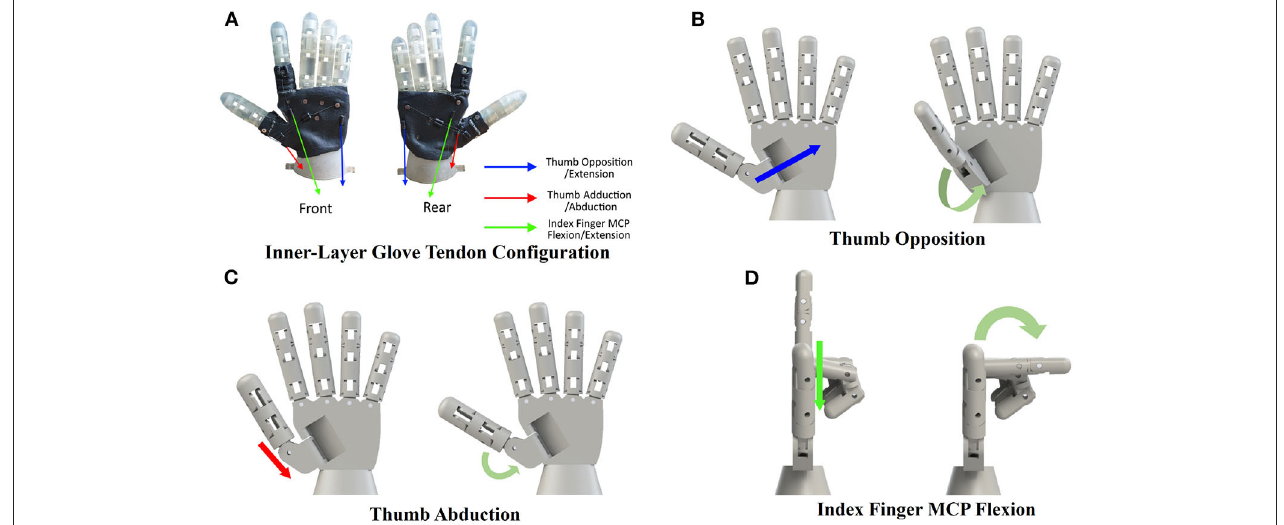
FIGURE 2 | Finger motions invoked by pulling tendons installed on the inside layer of the robot hand. (A) The robotic hand skeleton installed with the tendon sheaths for three different finger motions. Each arrow in different colors shows the target motion with a tendon pair. (B) Front view of thumb opposition motion by pulling the blue wire in (A) . (C) Front view of thumb abduction motion by pulling the red wire in (A) . (D) Side view of index finger’s MCP joint flexion by pulling the green wire in (A) .